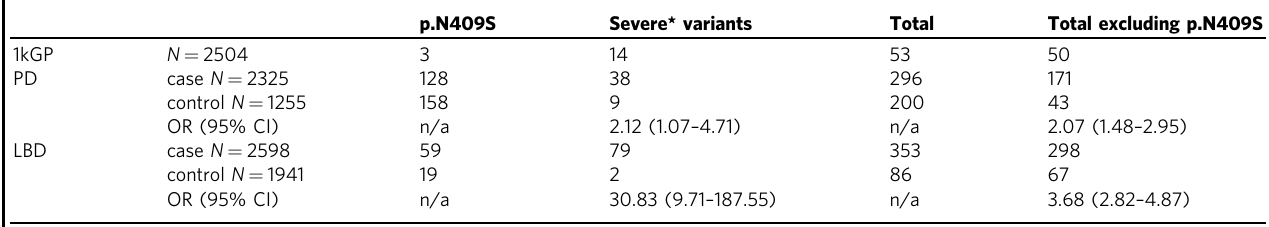
Table 4 Summary of samples carrying GBA coding variants detected in 1kGP, PD and LBD